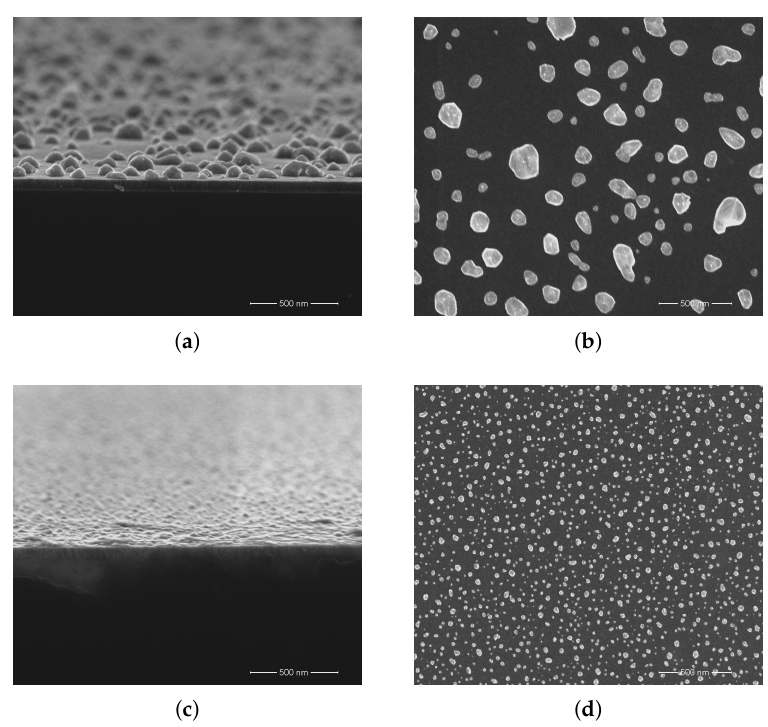
Figure 4. Scanning electron microscopy (SEM) micrographs at ( a , c ) 120,000 × and ( b , d ) 100,000 × magnification of the Ni catalyst layer after thermal annealing at 800 ◦ C in NH 3 atmosphere: ( a ) cross- section and ( b ) top-view of the ∼ 6–7 nm-thick annealed Ni layer; ( c ) cross-section and ( d ) top-view of the ∼ 2–3 nm-thick annealed Ni layer.